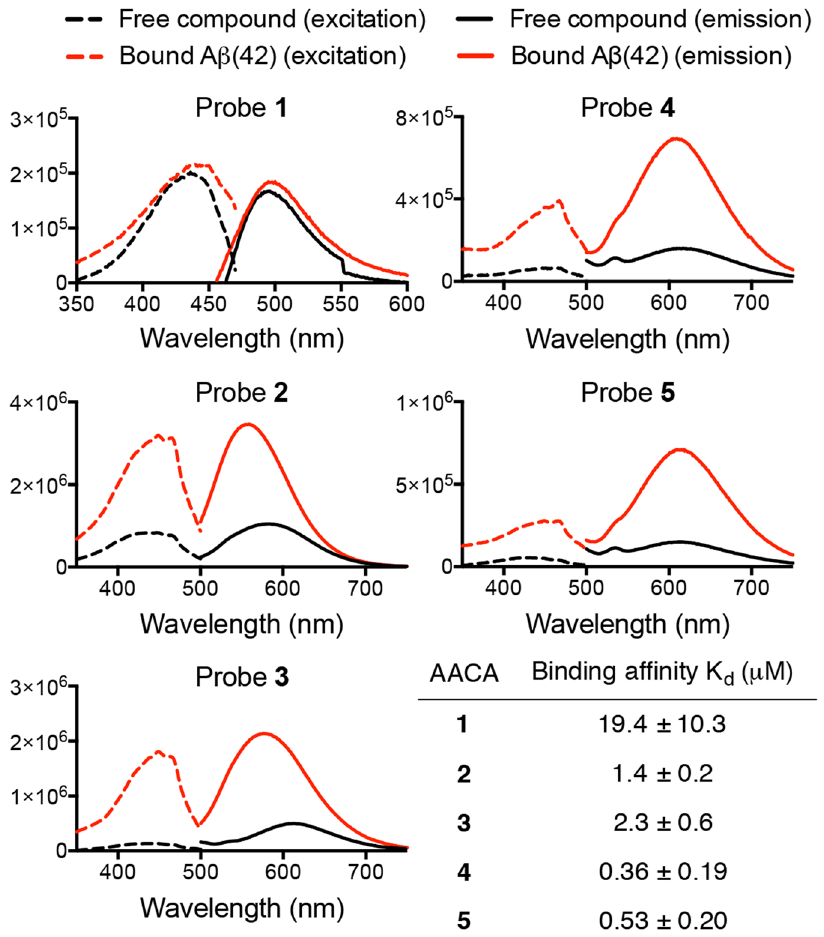
Figure 5. Fluorescence binding profiles and binding affinities of AACA probes 1–5 free (black) and bound (red) to β -amyloid (1–42) fibrils in